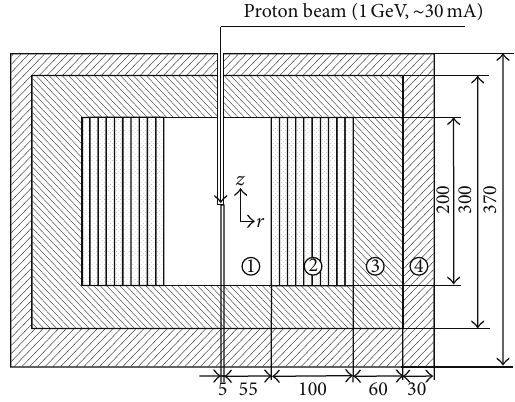
Figure 2: Cross-sectional view of the investigated ADS ( A SNT: spallation neutron target; B SCZ: Subcritical Core Zone; C RZ: reflector zone; D SZ: shielding zone; dimensions are in